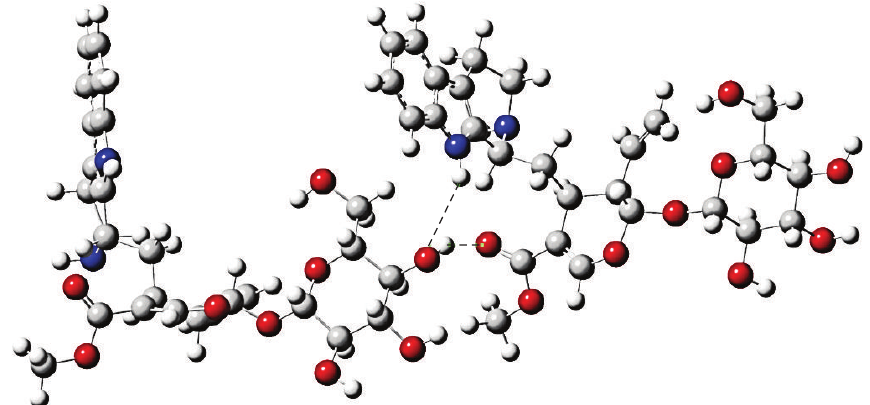
Figure 8: The strictosidine dimer, featuring hydrogen bonds (dashed line) between the tryptophanic and glycosidic